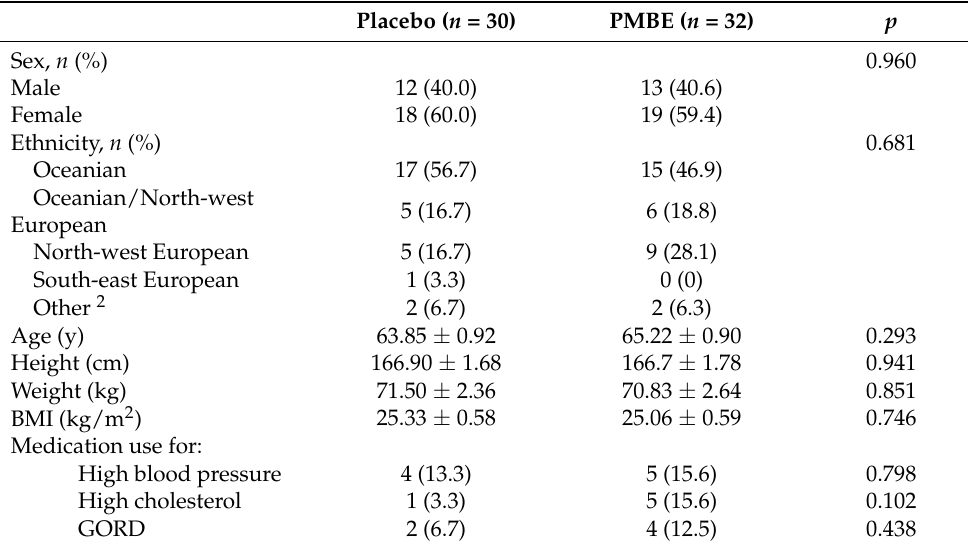
Figure 1. Flowchart of participant recruitment, screening, and assessment. Table 2. Participant characteristics at baseline in the placebo and PMBE groups 1 .